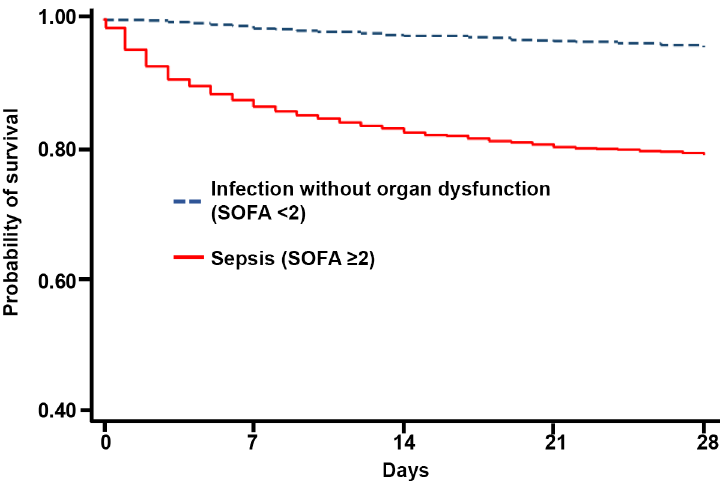
Fig 3. Survival curve comparing infected patients without organ dysfunction to patients with sepsis.